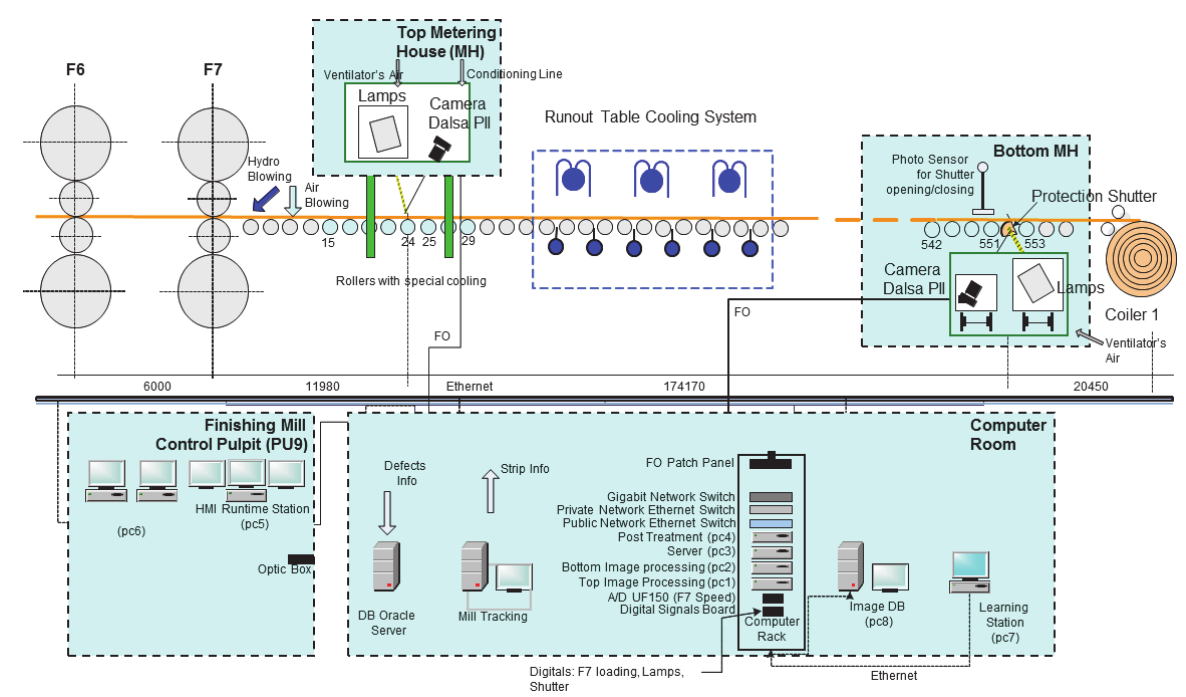
Figure 1: Placement of ASIS